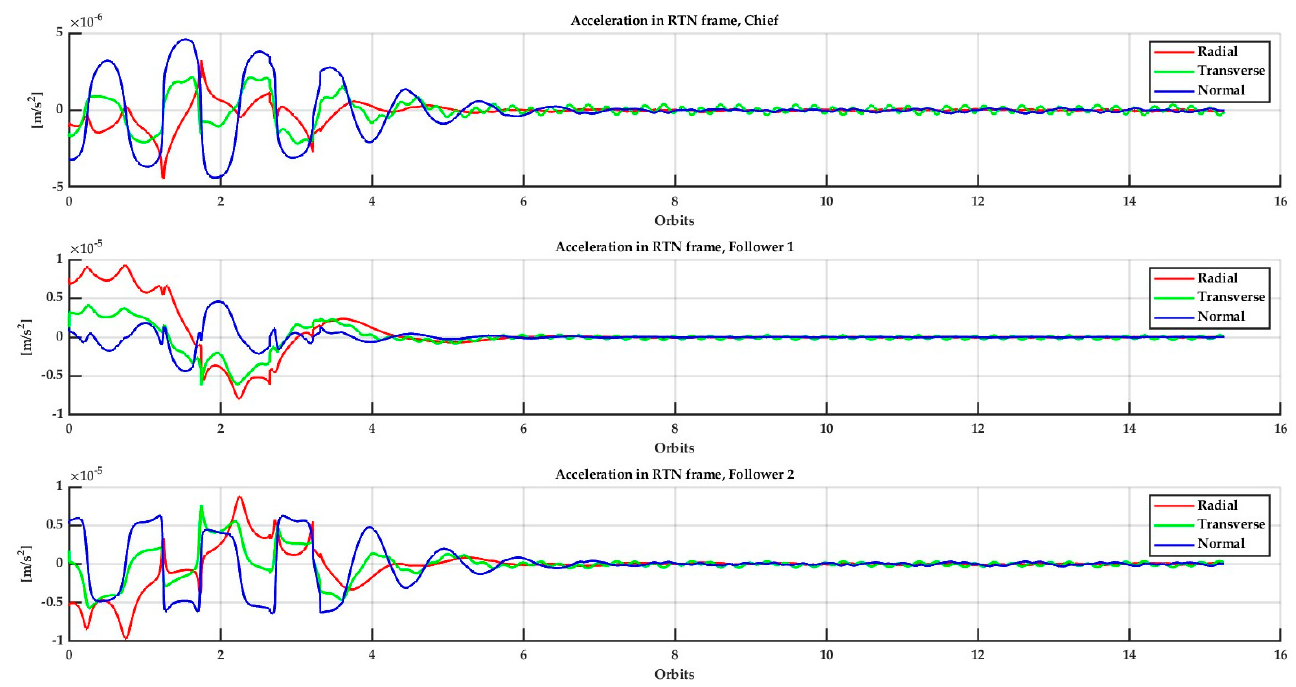
Figure 12. Control acceleration results with chief/follower mass ratio 𝛽 = 10 .